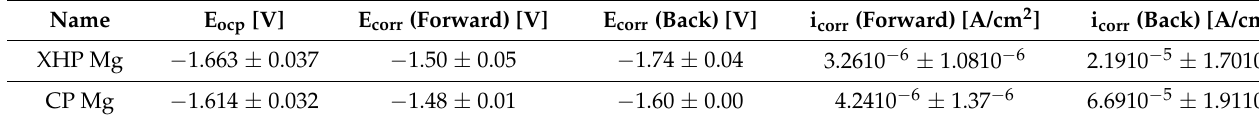
Table 4. Electrochemical measurement results, dynamic conditions